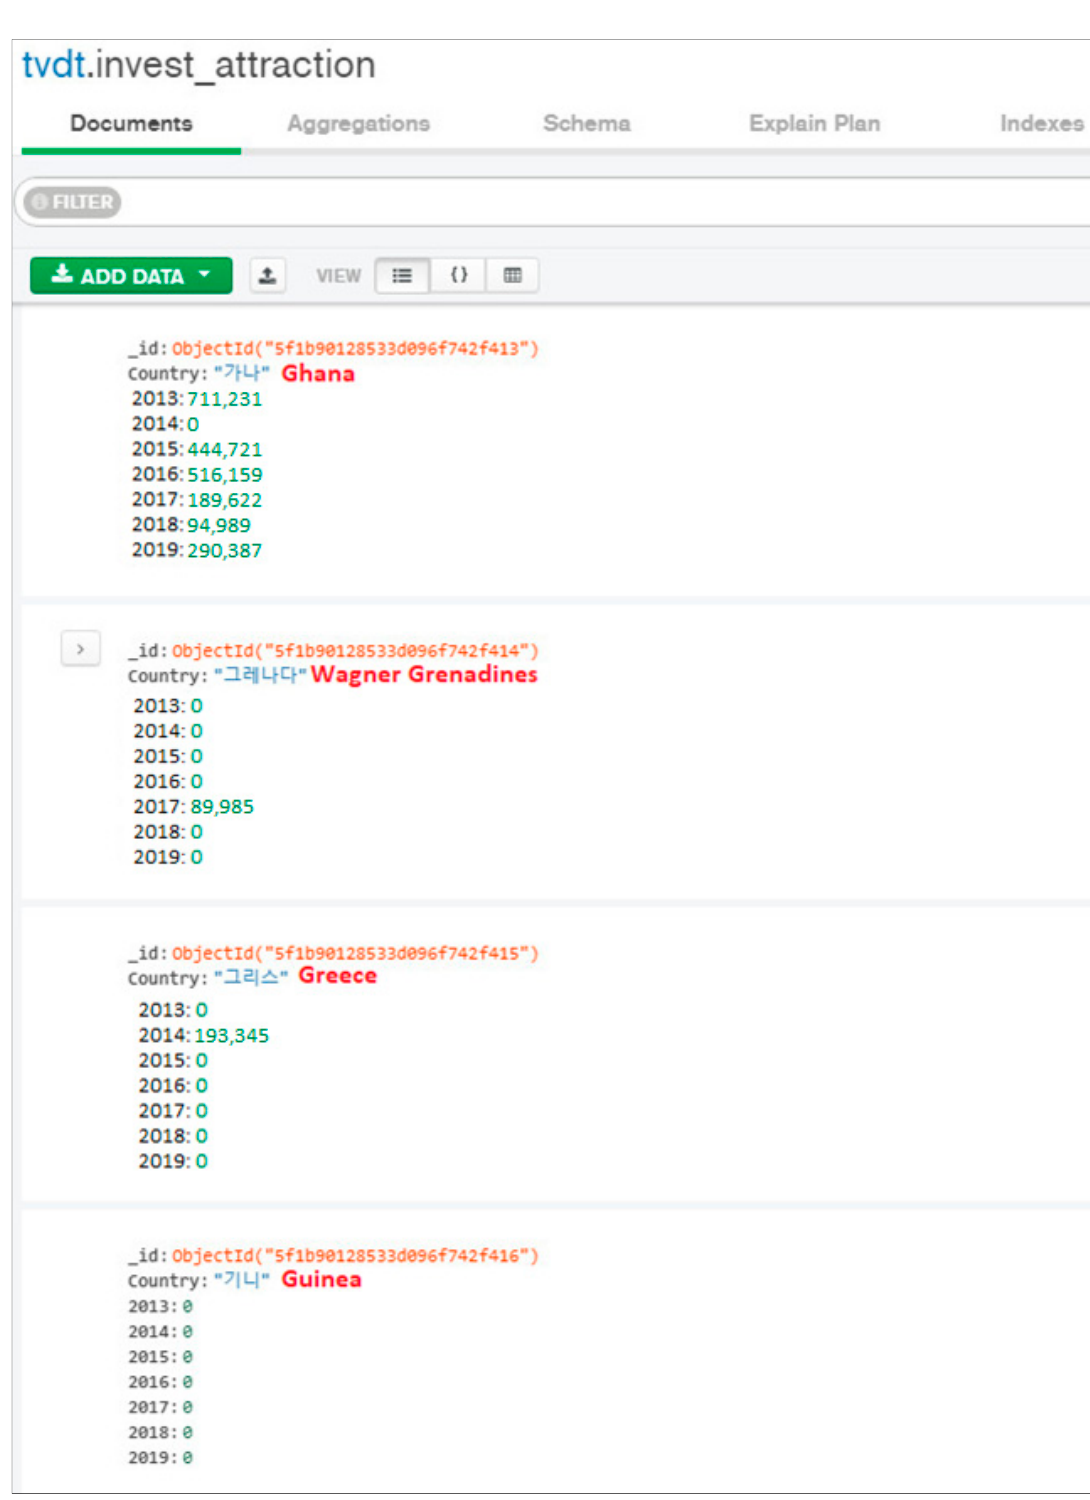
Figure 20. Databases of Invest attraction data.